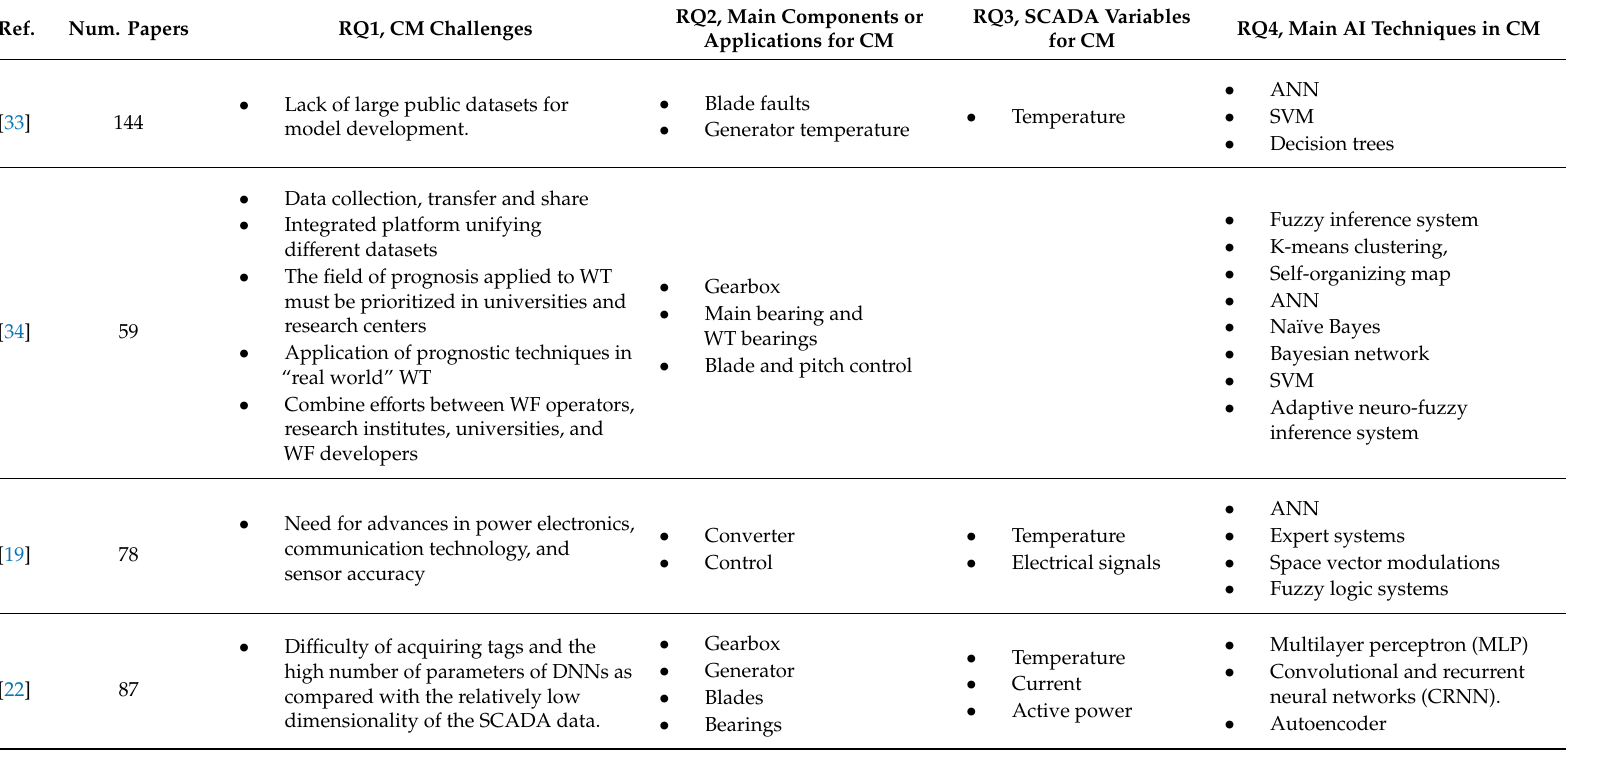
Table 3. Summary of findings and limitations in relation to the research questions formulated.